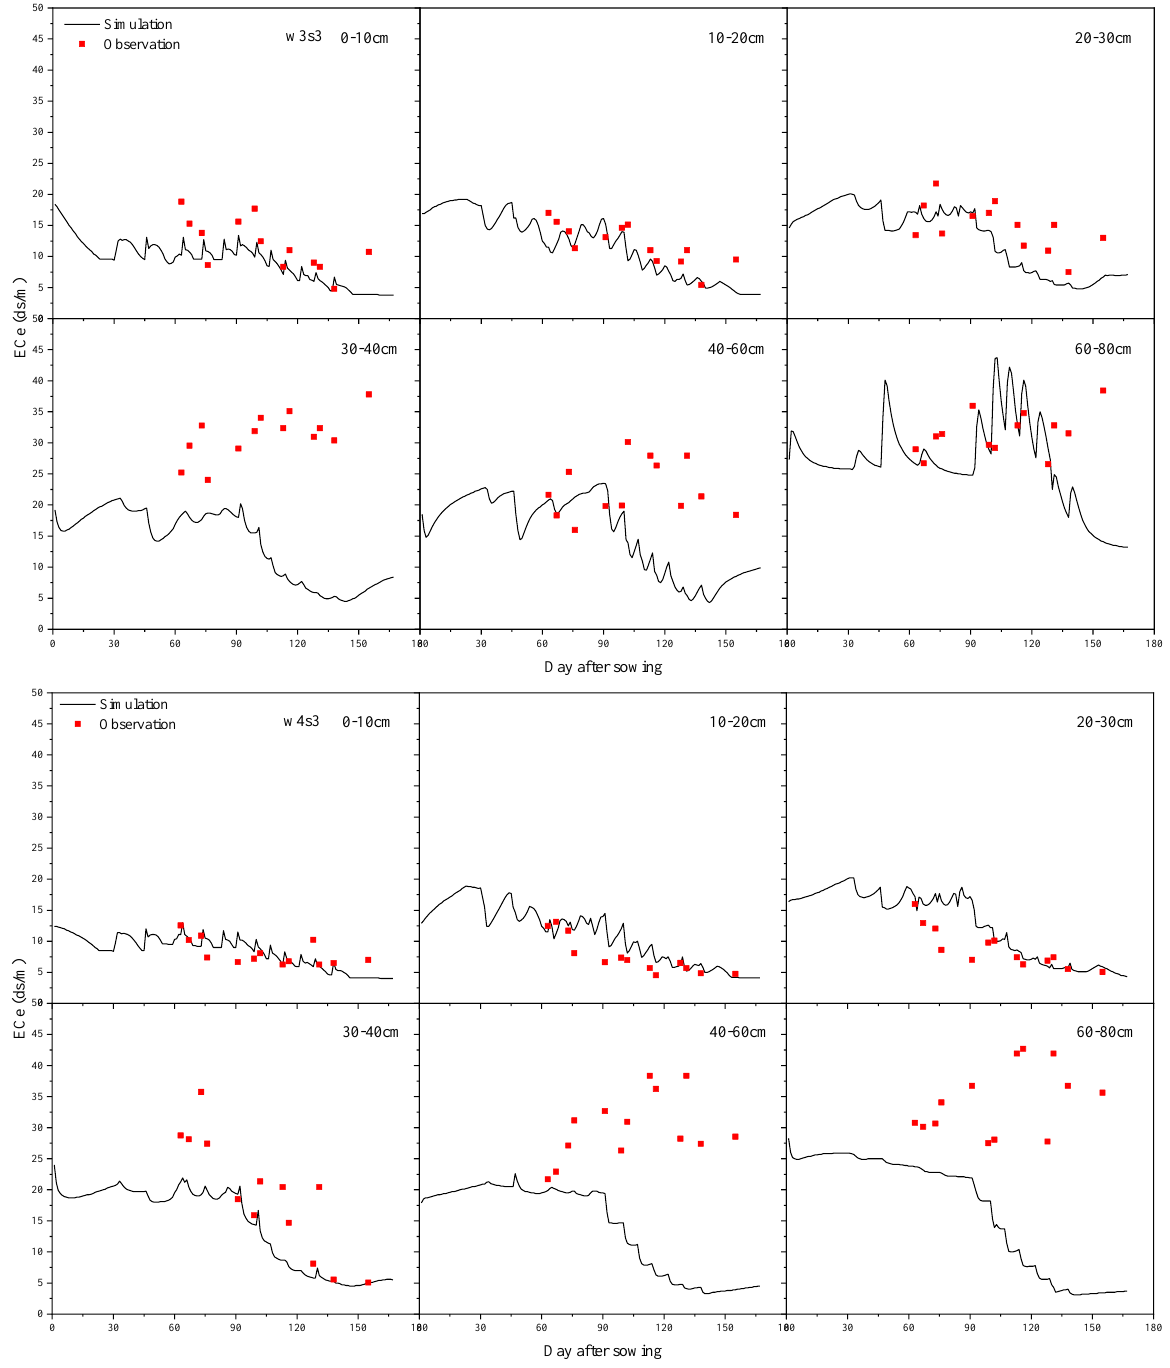
Figure 11. Comparison between observed and simulated ECe in the 0 – 80 cm soil profile for different irrigation and salinity treatments (W3S3; W4S3).